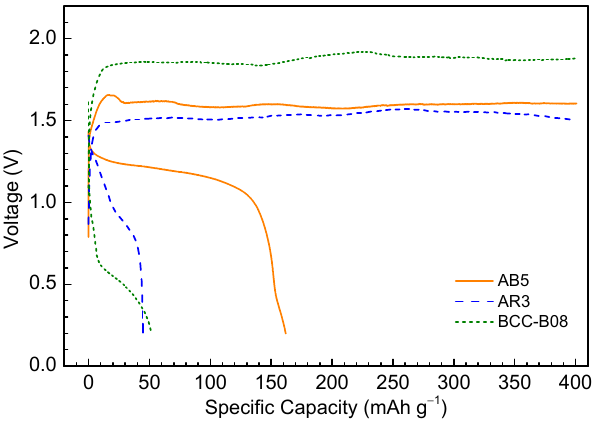
Figure 5. Deep charge/discharge characteristics of Ni/MH half-cells using three different metal hydride anodes: AB5, AR3, and BCC-B08. Electrolyte: 2 M acetic acid/[EMIM][Ac].